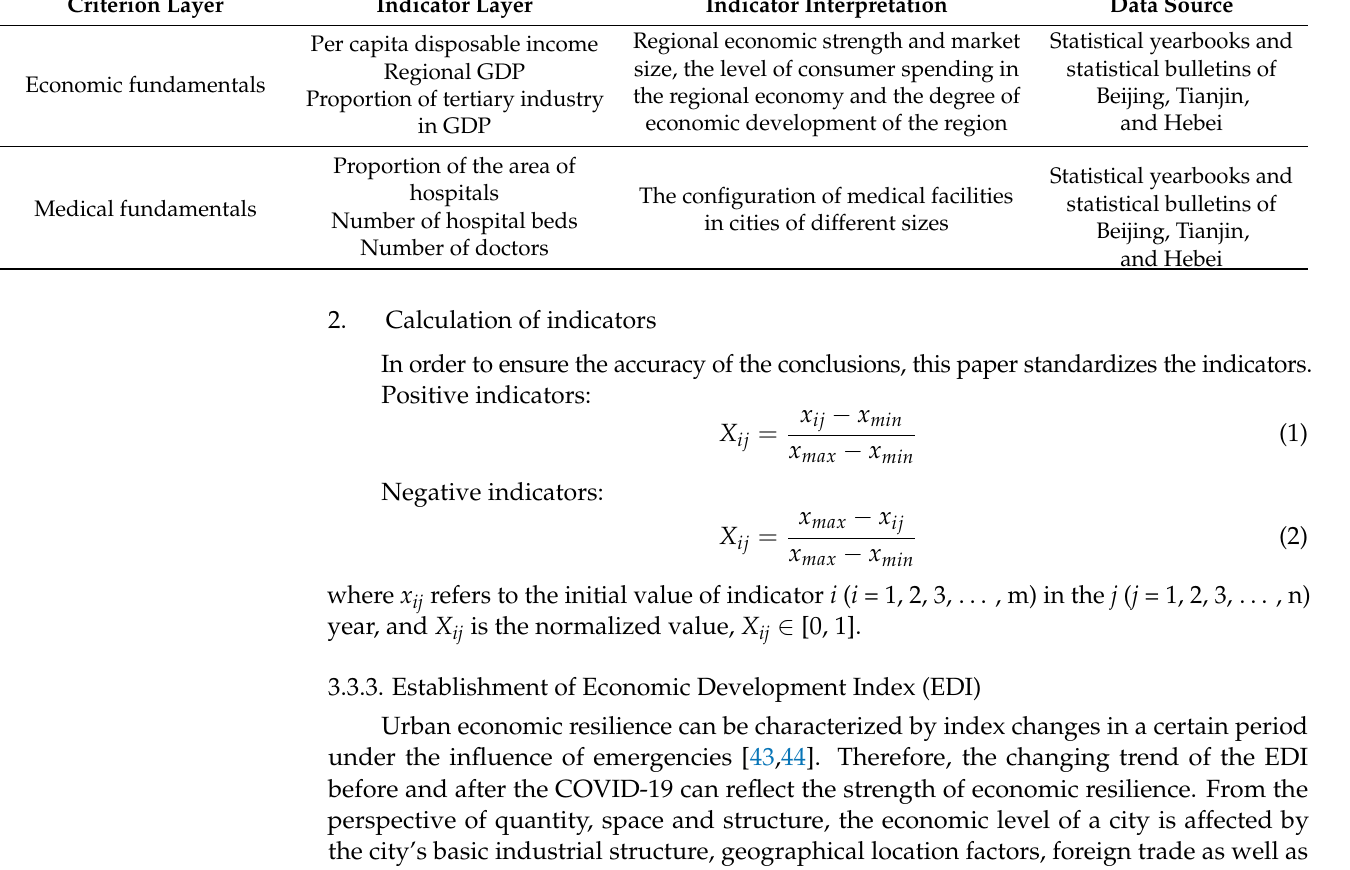
Table 1. The indicator system of the urban fundamentals of the Beijing–Tianjin–Hebei urban agglomeration. Criterion Layer Indicator Layer Indicator